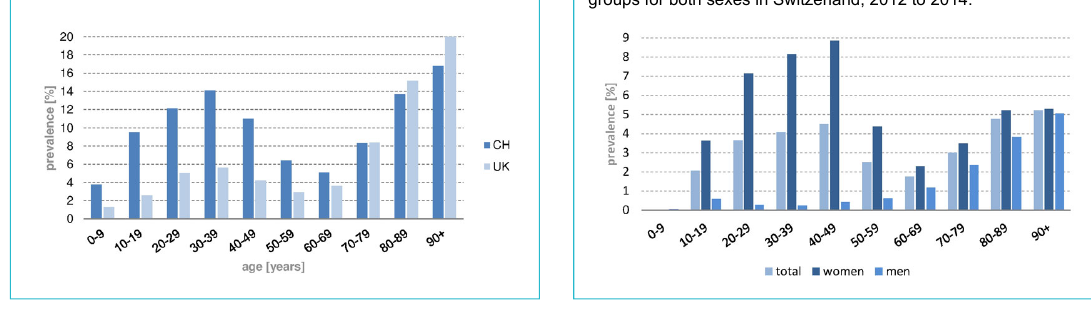
Figure 4: Prevalence of parenteral iron substitution in different age groups for both sexes in Switzerland, 2012 to 2014.